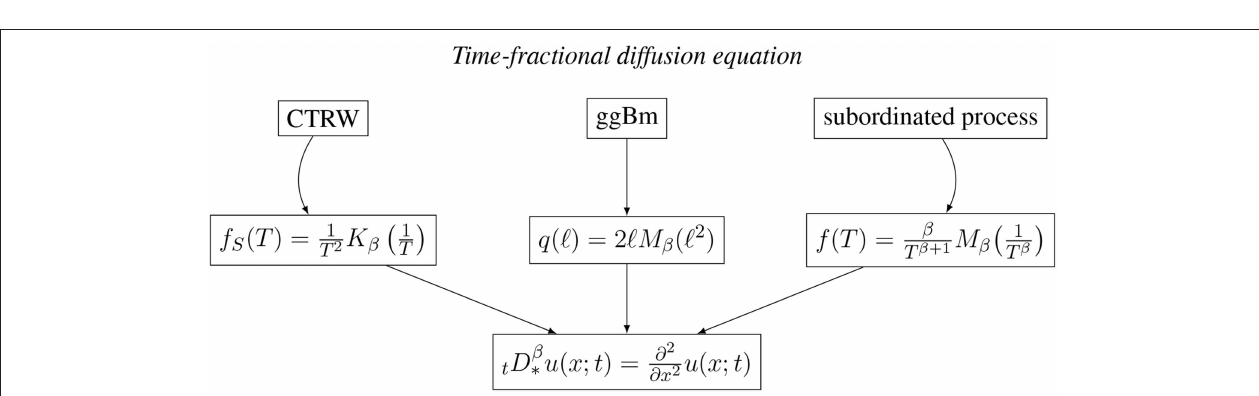
FIGURE 2 | Schematic picture of the three stochastic processes in heterogenous media leading to the same time-fractional diffusion equation for the 1-point 1-time PDF.